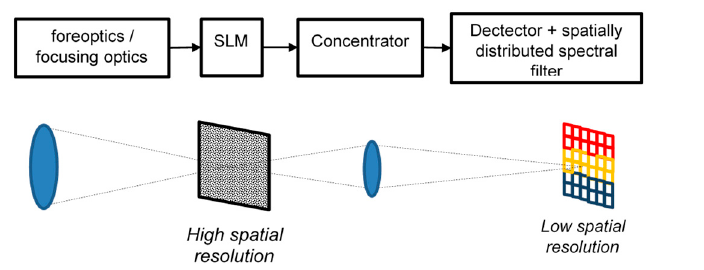
Figure 2. Super-resolution approach: working principle and optical block diagram of the instrument.